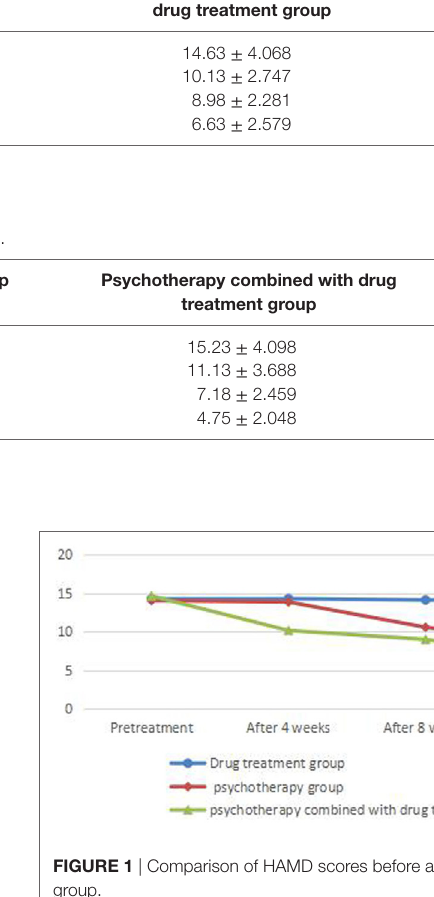
TaBle 1 | Comparison of HAMD scores before and after treatment in each group. Drug treatment group Psychotherapy